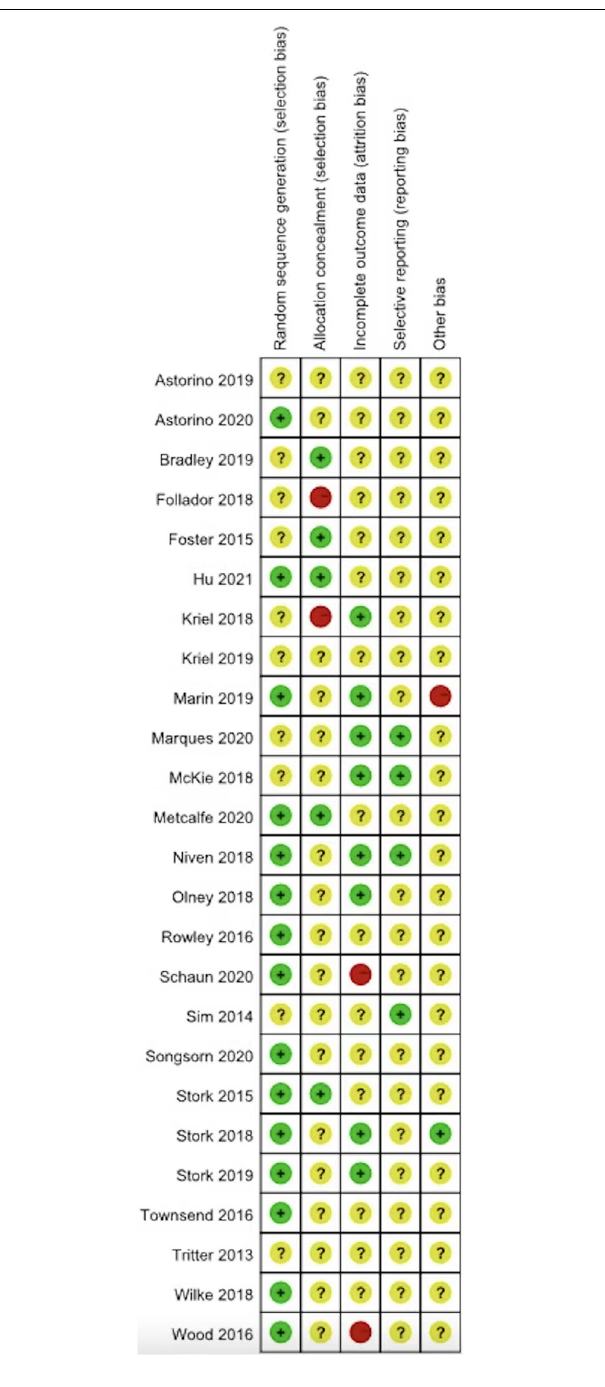
FIGURE 2 | Individual study of risk of bias assessment.